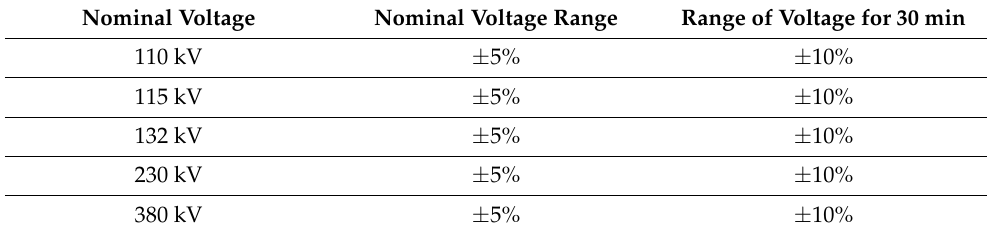
Table 2. Voltage requirements as per the SAGC